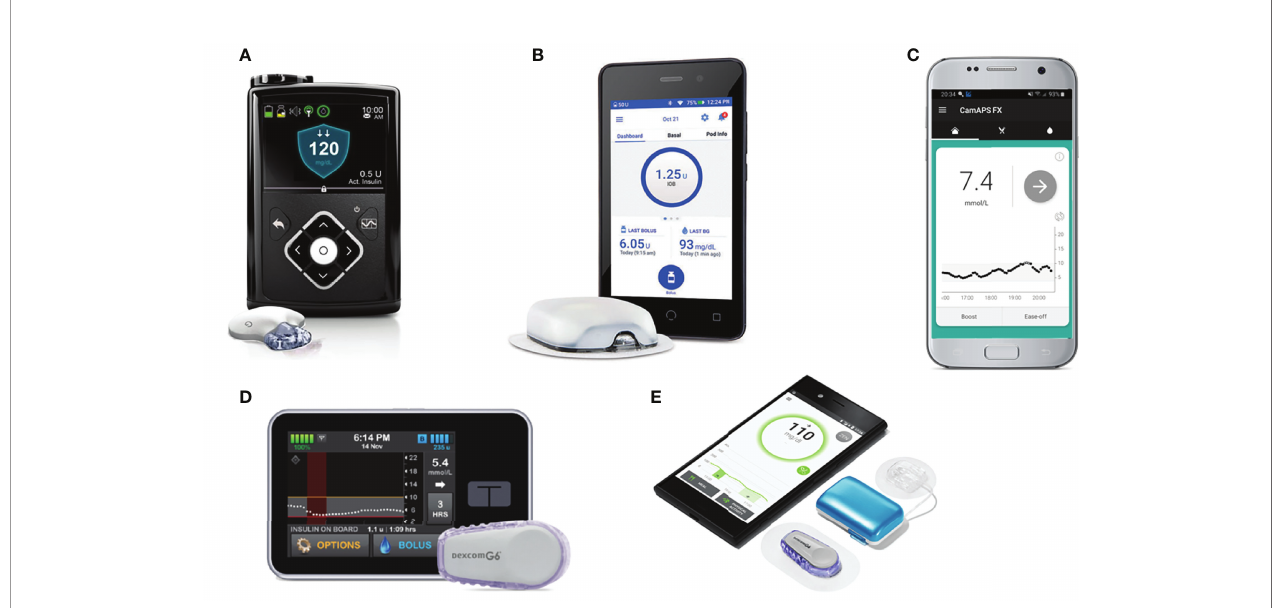
FIGURE 3 | Commercially available and in-development hybrid closed-loop systems. (A) MiniMed 670G with Guardian Link 3 sensor/transmitter. (B) Omnipod Horizon with patch-pump. (C) CamAPS FX algorithm hosted on Android. (D) Tandem t:slim X2 pump paired with Dexcom G6 sensor. (E) Diabeloop DLBG1 algorithm with Kaleido patch-pump and Dexcom G6